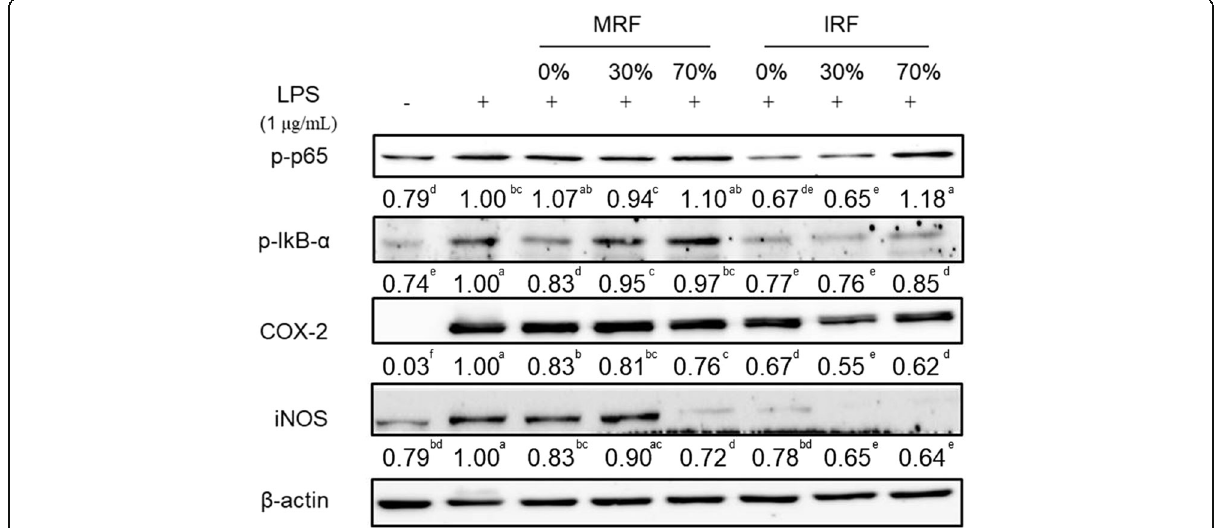
Fig. 4 Anti-inflammatory effect of extracts from Rubus coreanus fruit (RF) on RAW264.7 protein expression. Cells were pretreated with 200 μ g/mL mature RF (MRF) and immature RF (IRF) for 1 h and then induced with 1 μ g/mL LPS for 18 h. Cells were lysed and proteins were employed by SDS-PAGE followed by Western blotting using primary antibodies targeting anti-p-p65, p-ikB-a, COX-2, iNOS and β -actin. . The data depicted in the bend below as the means are an average of three similar and independent experiments and gel images are of representative blots. Means with different letters are significantly different at p < 0.05 by Tukey ’ s multiple comparison